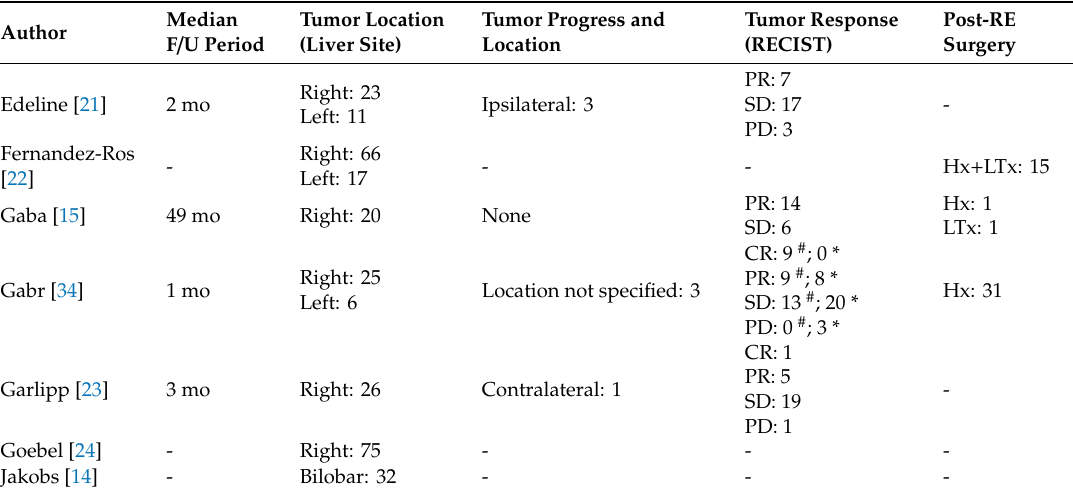
Table 3. Overview of the oncological